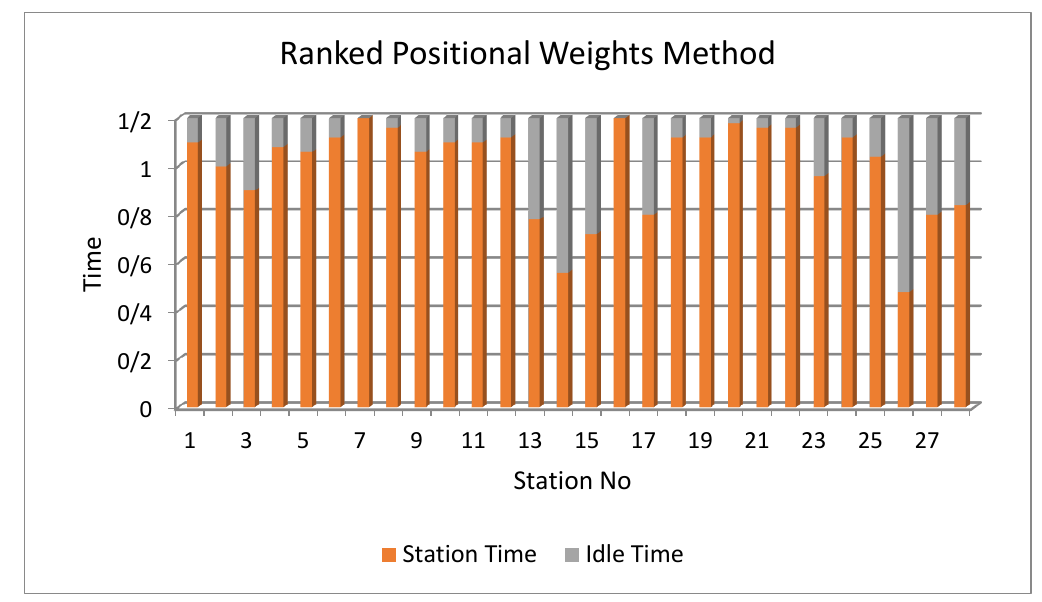
Figure 9. Service time and idle time of RPW